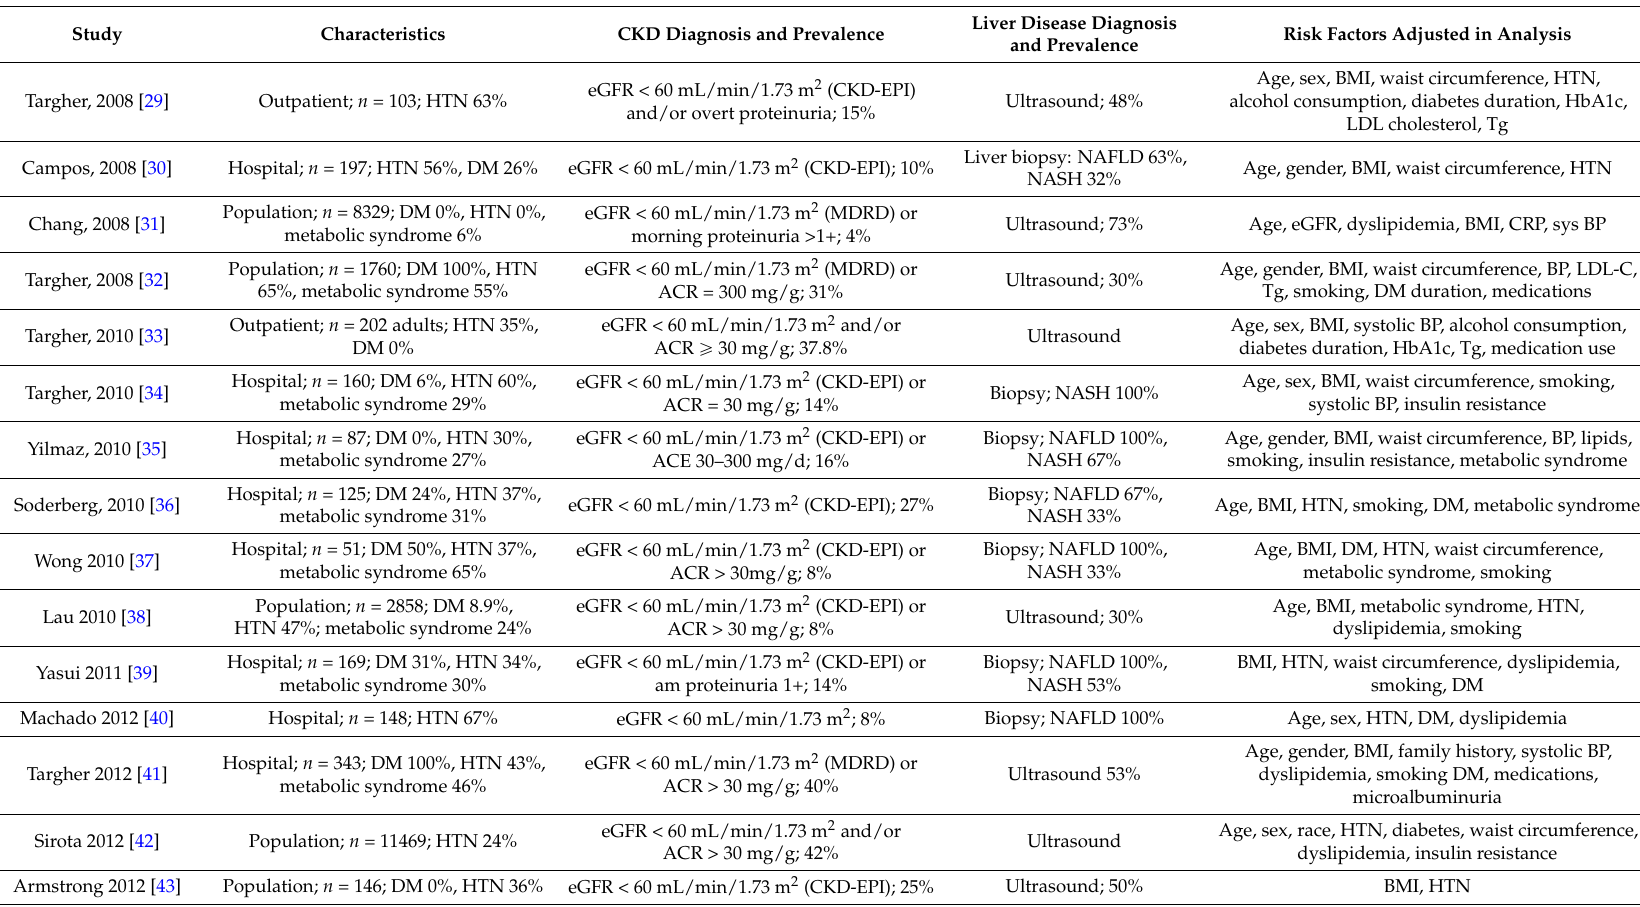
Table 2. Principal retrospective studies of the association between nonalcoholic fatty liver disease and the prevalence of chronic kidney disease (CKD). Study Characteristics CKD Diagnosis and Prevalence